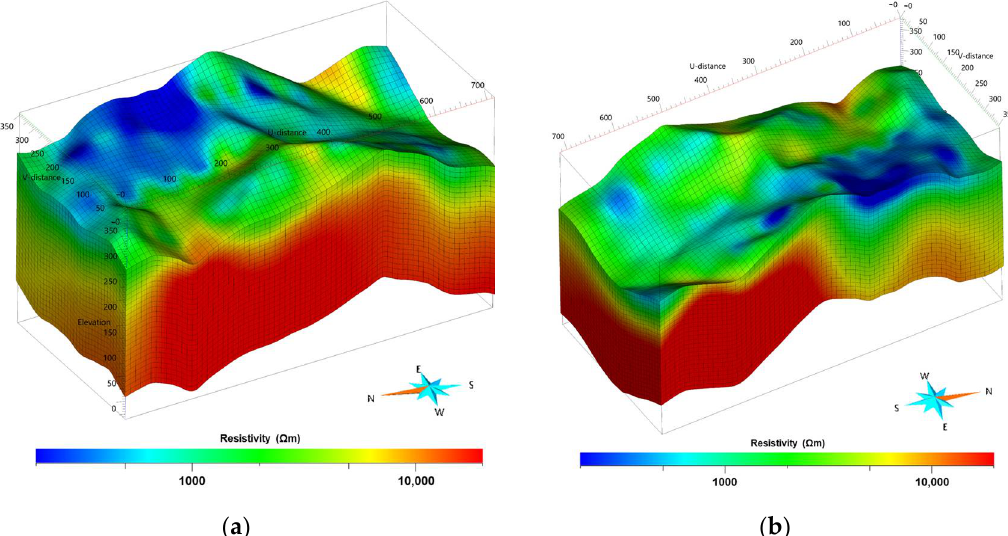
Figure 5. Three-dimensional inversion results of electrical resistivity with frontal direction of ( a ) survey line 1 and ( b ) survey line 3.